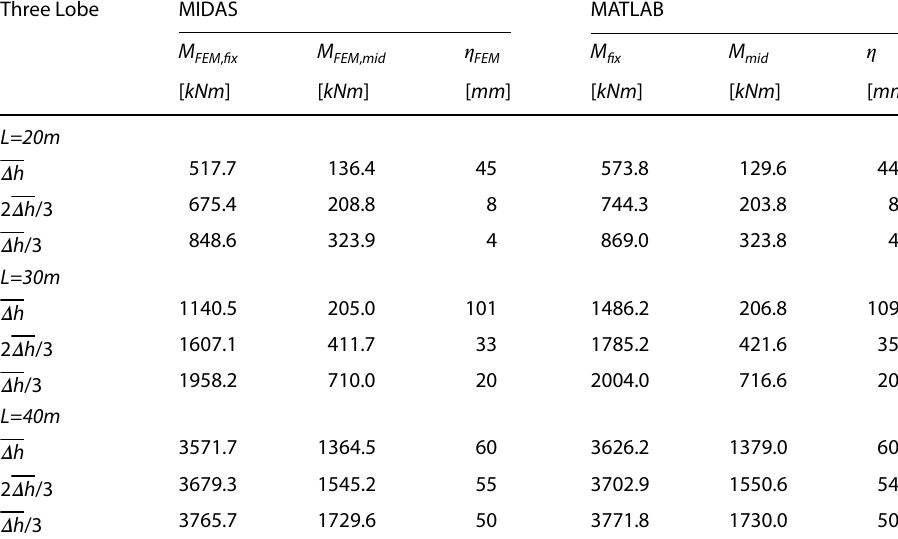
Table 3 Comparison of bending moments at fixed joint ( M fix ) and in midspan